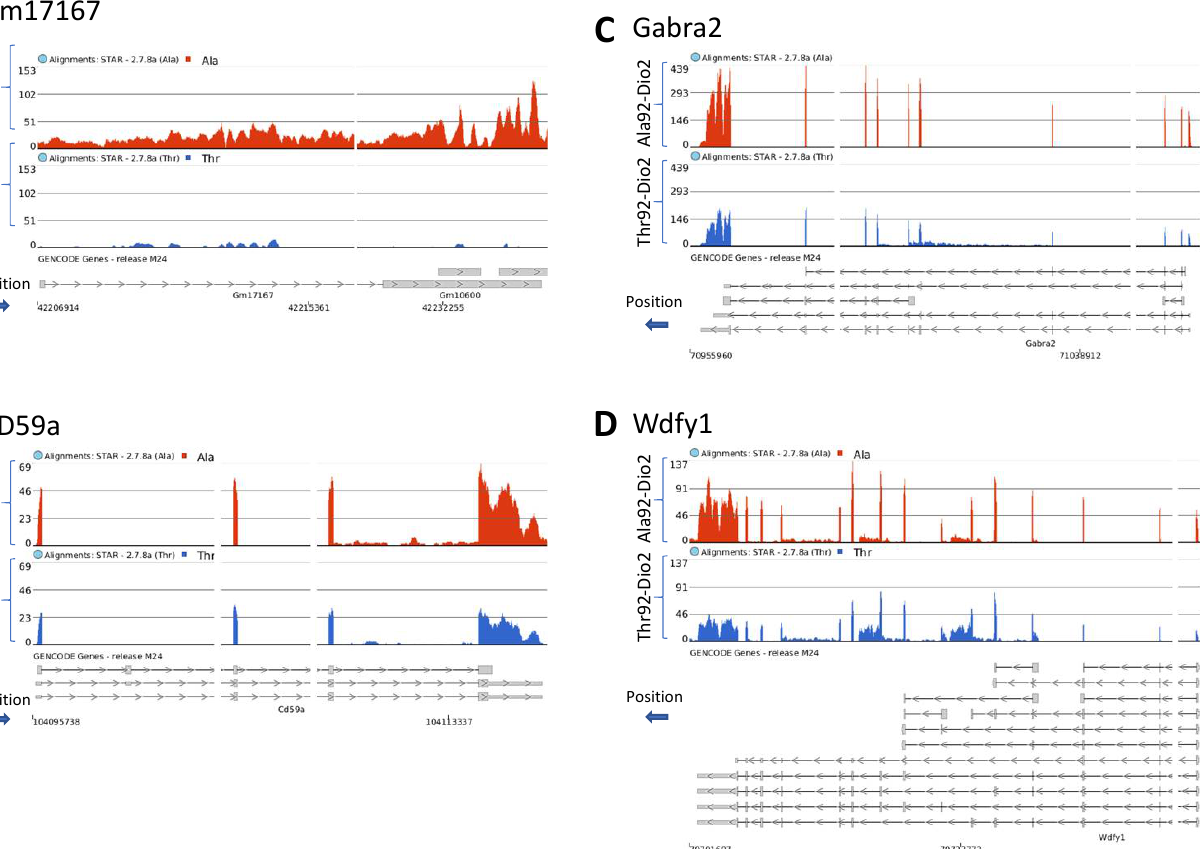
Figure 5. Gene expression coverage in the Ala92-Dio2 mice. ( A – D ) browser Integrative Genomics Viewer (IGV)-display of transcript areas of selected genes (4 representative genes out of a total of 29 genes that overlapped in the pre-frontal cortex and hippocampus of male and female mice) that are upregulated in Ala92-Dio2; the gene names are indicated at the top of each panel along with the blue arrow indicating the direction of transcription; the red tracks reflect the coverage for the Ala92-Dio2 RNA-seq data, and the blue tracks reflect the Thr92-Dio2 Rna-seq